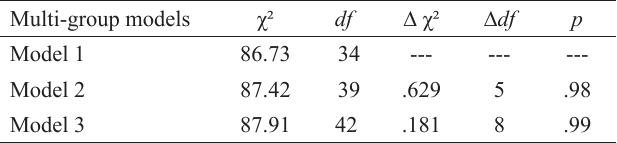
constrained models of the